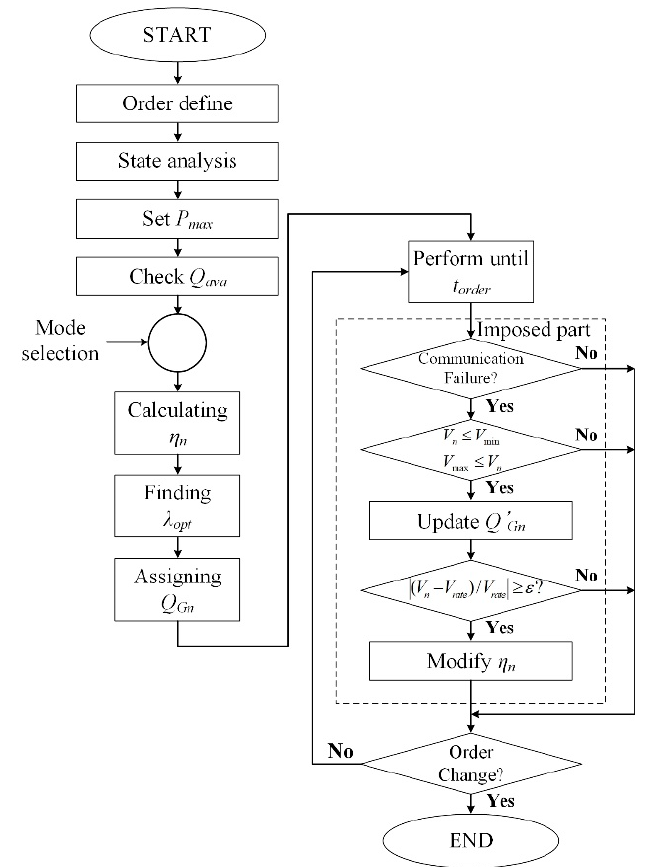
Figure 4. Entire control flow chart, including newly imposed calculation.